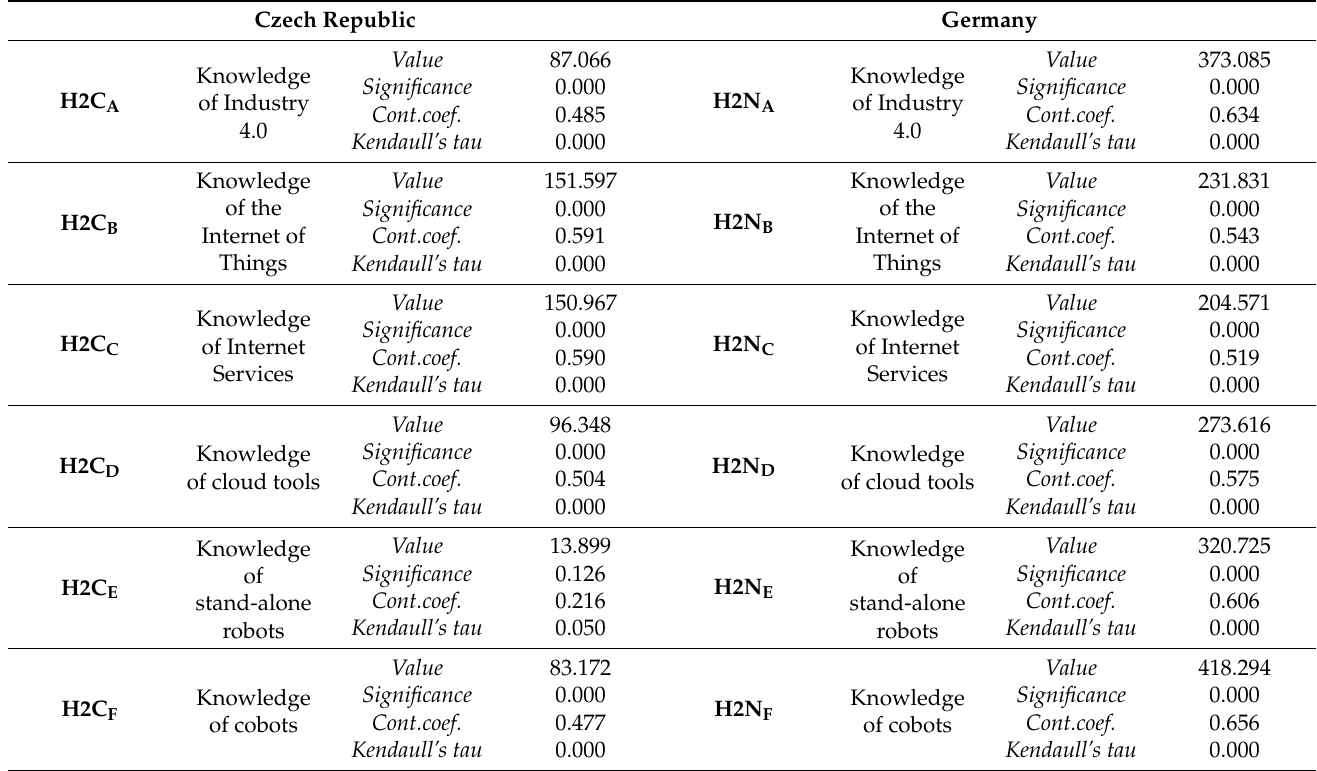
Table 2. Gained results for sub-hypotheses H2—preparedness to